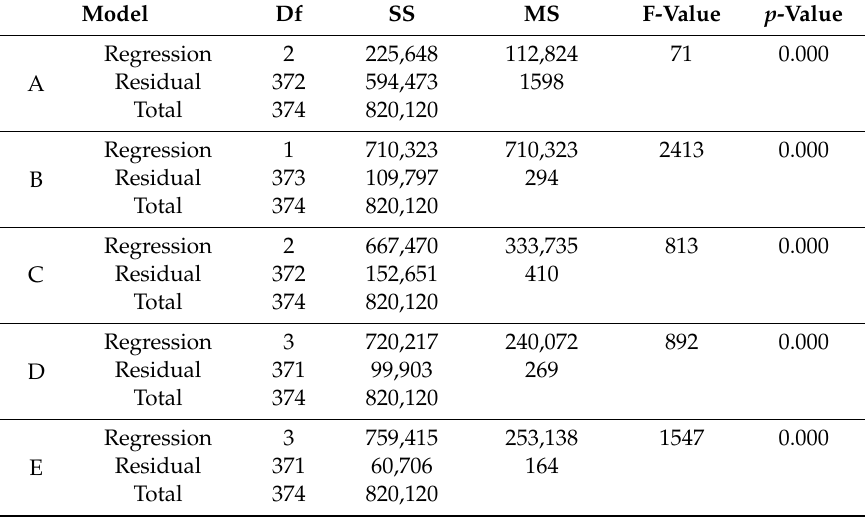
Table 7. Results of the analysis of variance (ANOVA) for each prediction regression